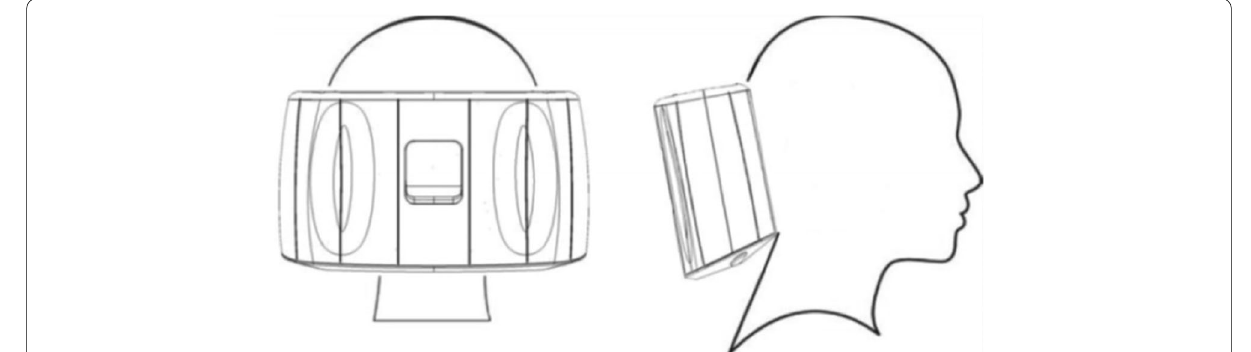
Fig. 1 Spring TMS optimal placement and coil locations